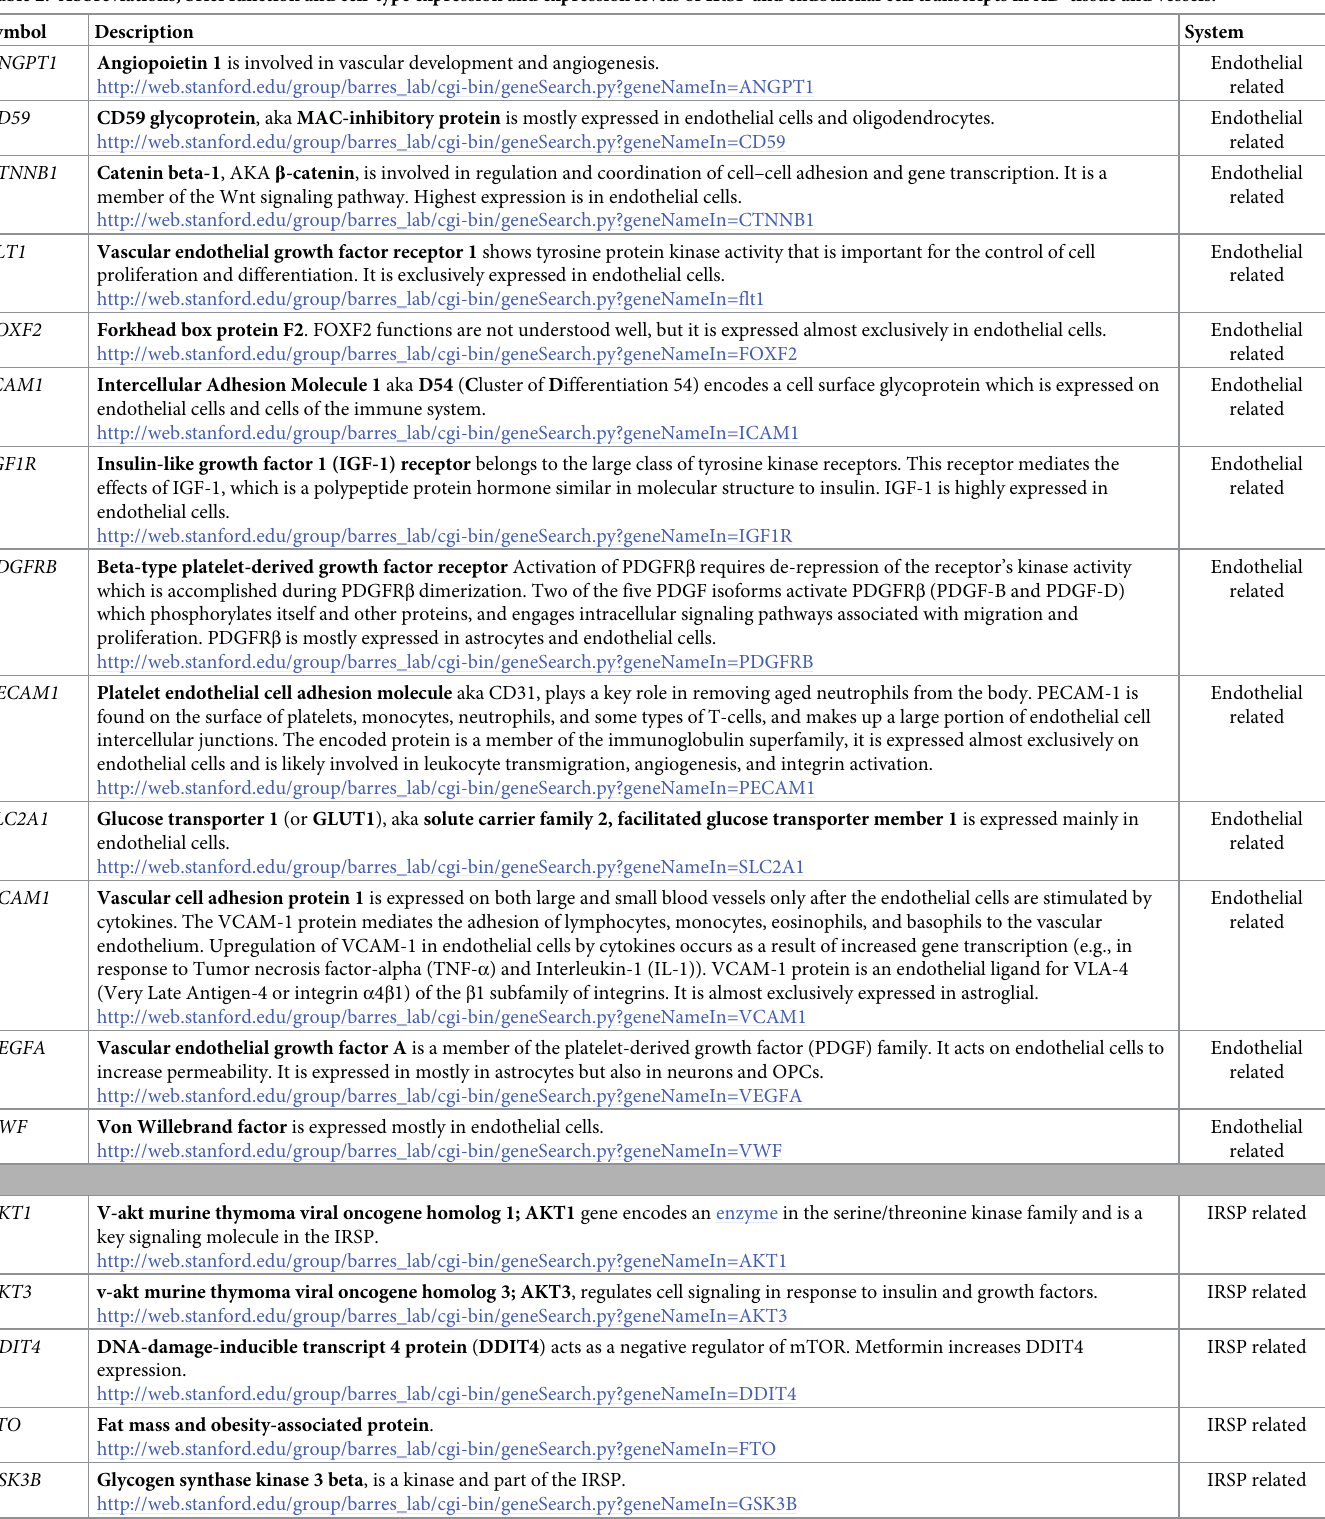
Table 2. Abbreviations, brief function and cell-type expression and expression levels of IRSP and endothelial cell transcripts in AD-tissue and vessels.